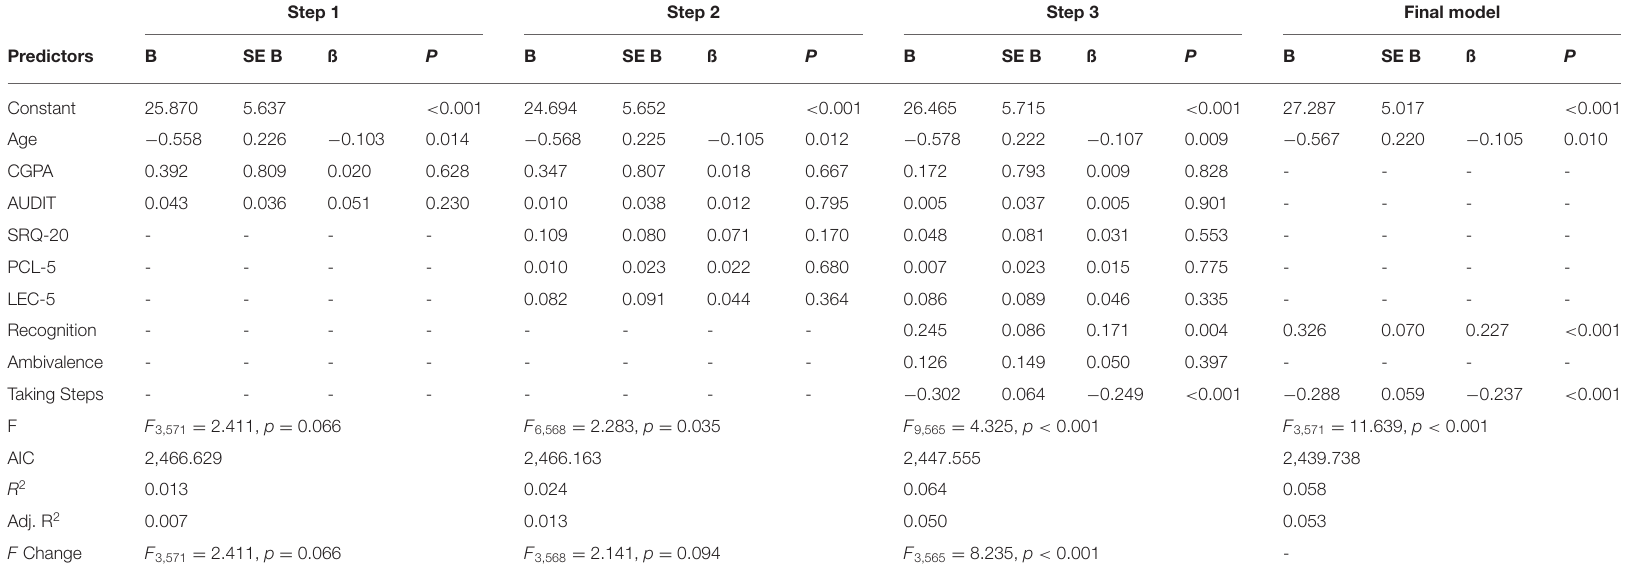
TABLE 2 | Summary of the linear regression model of dependent variable days of khat use in the last 28 days.